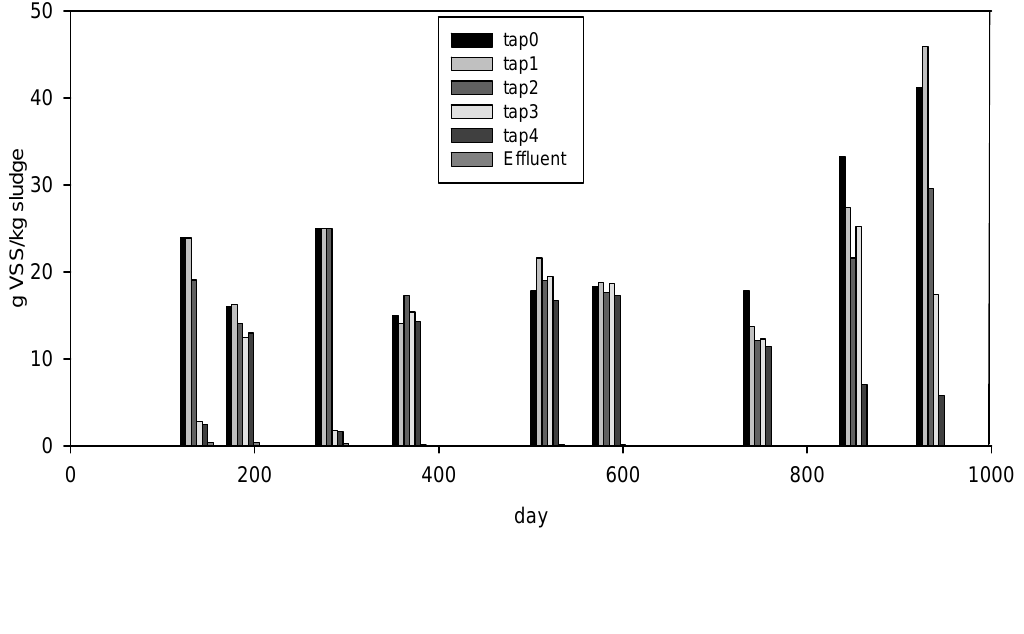
Figure 4. Sludge bed development (upper graph), the amount of sludge wasted (lower graph) and VSS/TSS ratio of the wasted sludge (lower